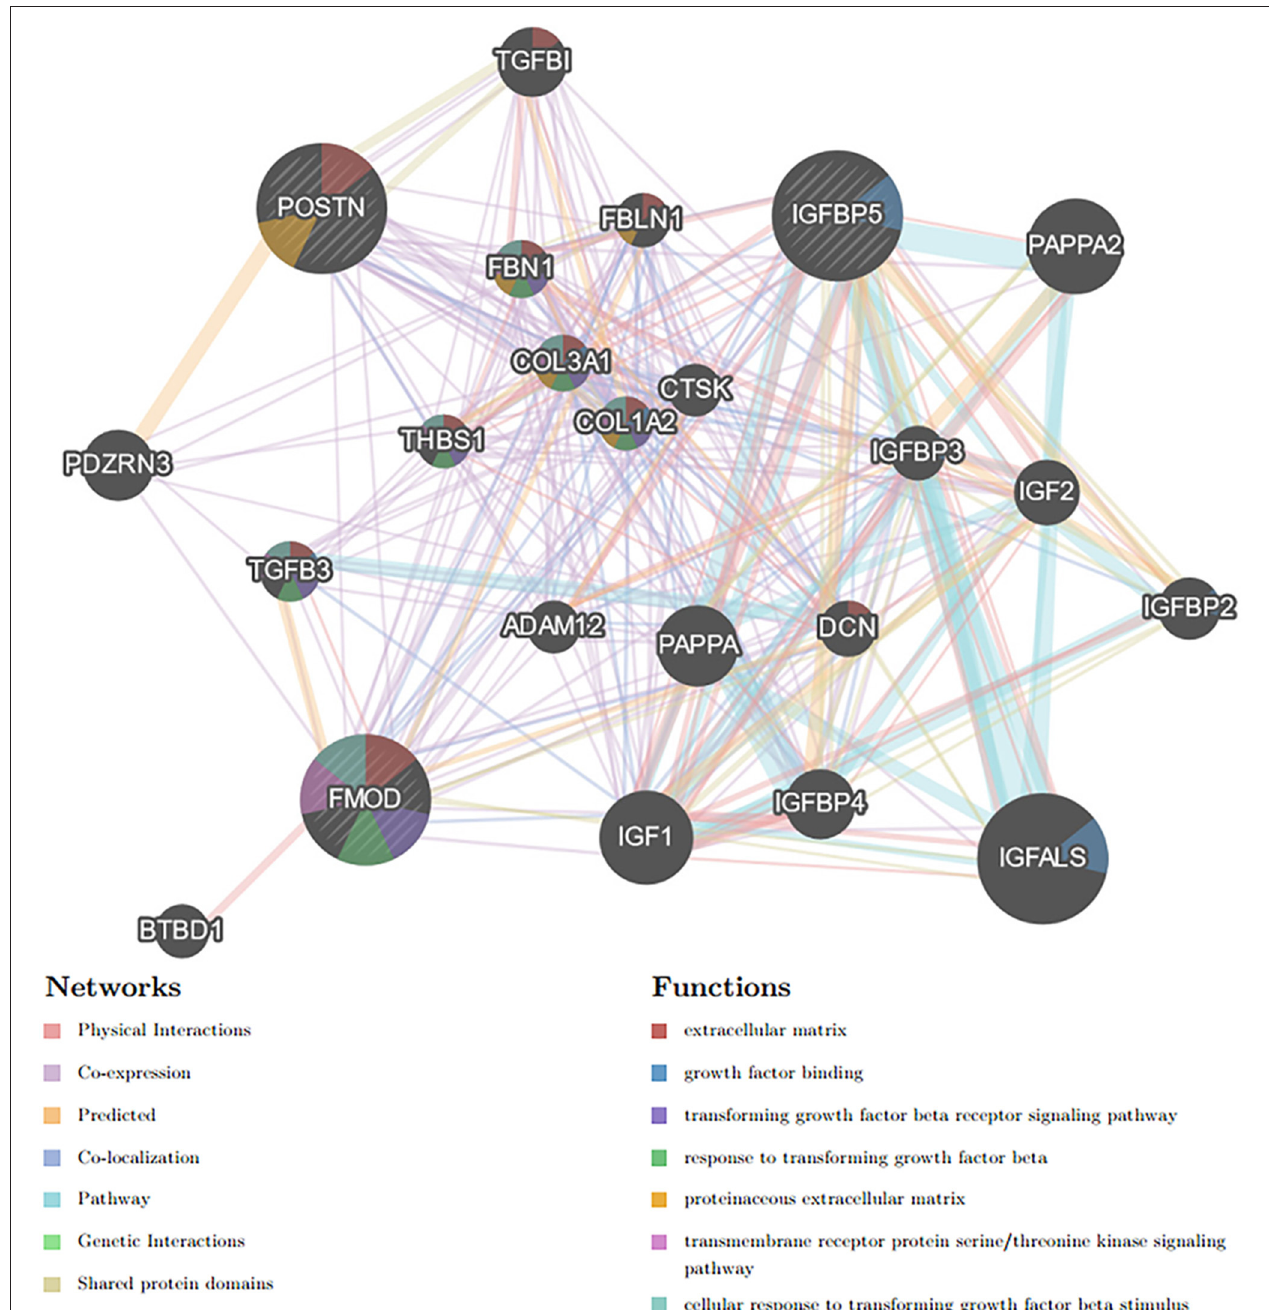
FIGURE 7 | Hub genes and their co-expression genes were analyzed using